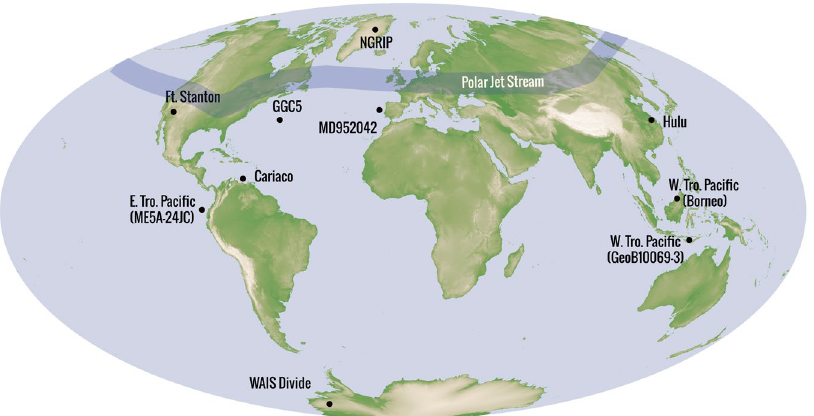
Figure 1. Geographic distribution of Northern Hemisphere climate proxies compared in this study and the schematic of the polar jet stream. Fort Stanton (FS-AH1), New Mexico USA (this study), NGRIP ice core record 5 , marine core MD95-2042 from the Iberian margin 25, 26 , West Antarctic Ice Sheet (WAIS) Divide ice core 22 , Bermuda Rise marine core GGC5 4 , Hulu (speleothem record) 10 , Cariaco Basin marine record 9 , Borneo speleothem record 8 , eastern tropical Pacific marine core ME0005A-24JC 2 , western tropical Pacific marine core GeoB10069-3 34 . Base map: NASA high-resolution topographic map of the earth from Shuttle Radar Topography Mission (SRTM) radar data (https://earthobservatory.nasa.gov/Features/ShuttleRetrospective/page6.php). Proxy locations done using Adobe Illustrator v. CC (http://www.adobe.com/products/illustrator.html).